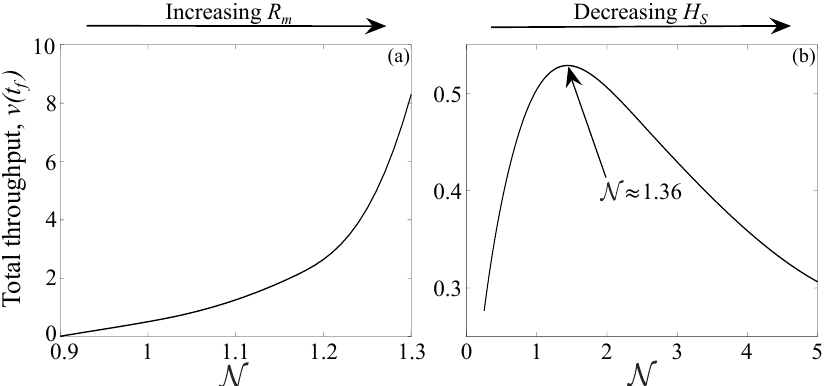
Figure 7. Total throughput v ( t f ) as a function of the packing density factor N , with parameter values φ = 0.5, β = 0.02, ρ b = 2, b = 0.5 when: ( a ) the radius of the membrane area R m and ( b ) the support layer thickness H s , varies. In ( b ), l = 0.5, (cid:101) ∗ =